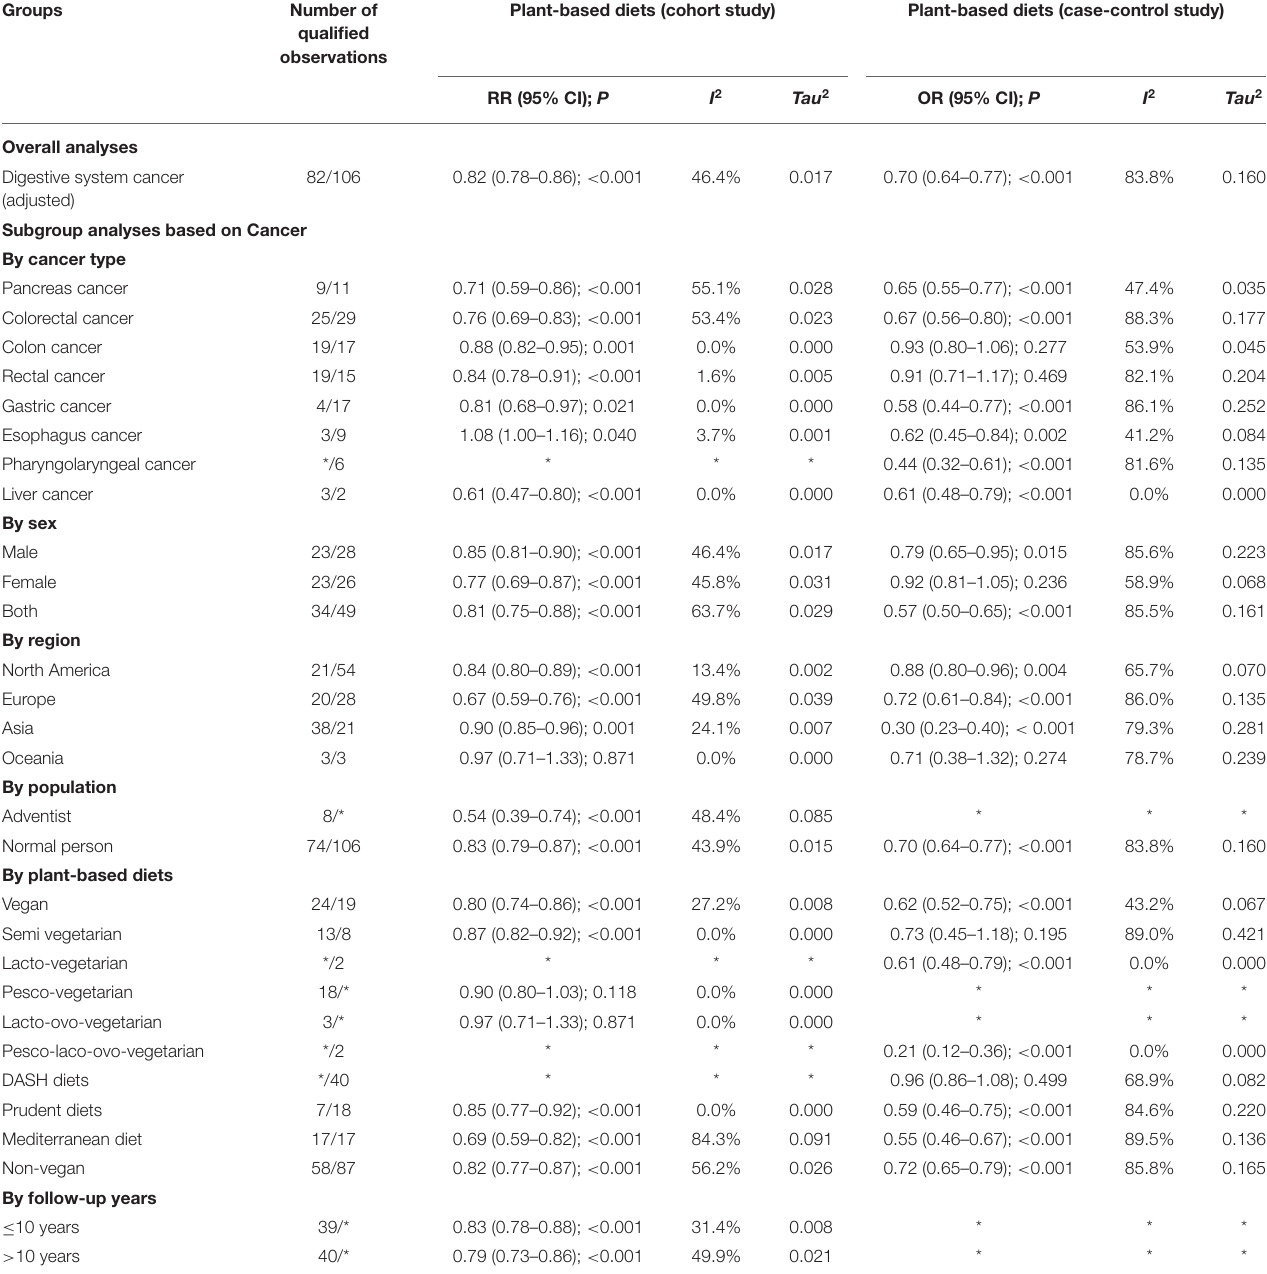
TABLE 1 | Overall and subgroup analyses of plant-based diets and digestive cancer risk.